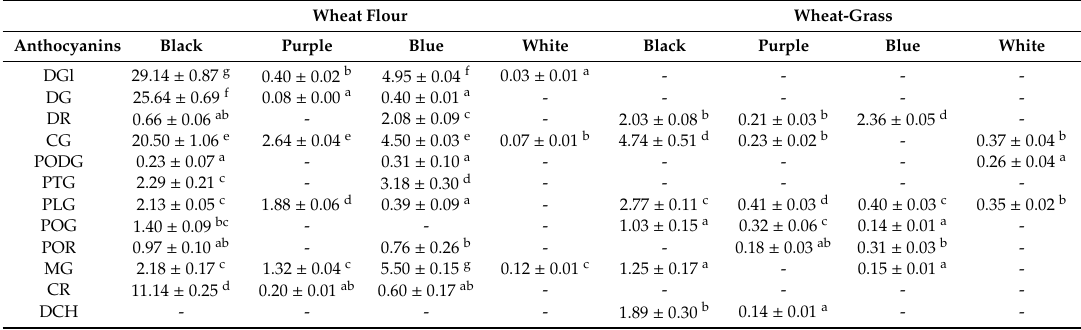
Table 1. Concentration of di ff erent anthocyanins (ppm) present in wheat flour and wheat-grass juice